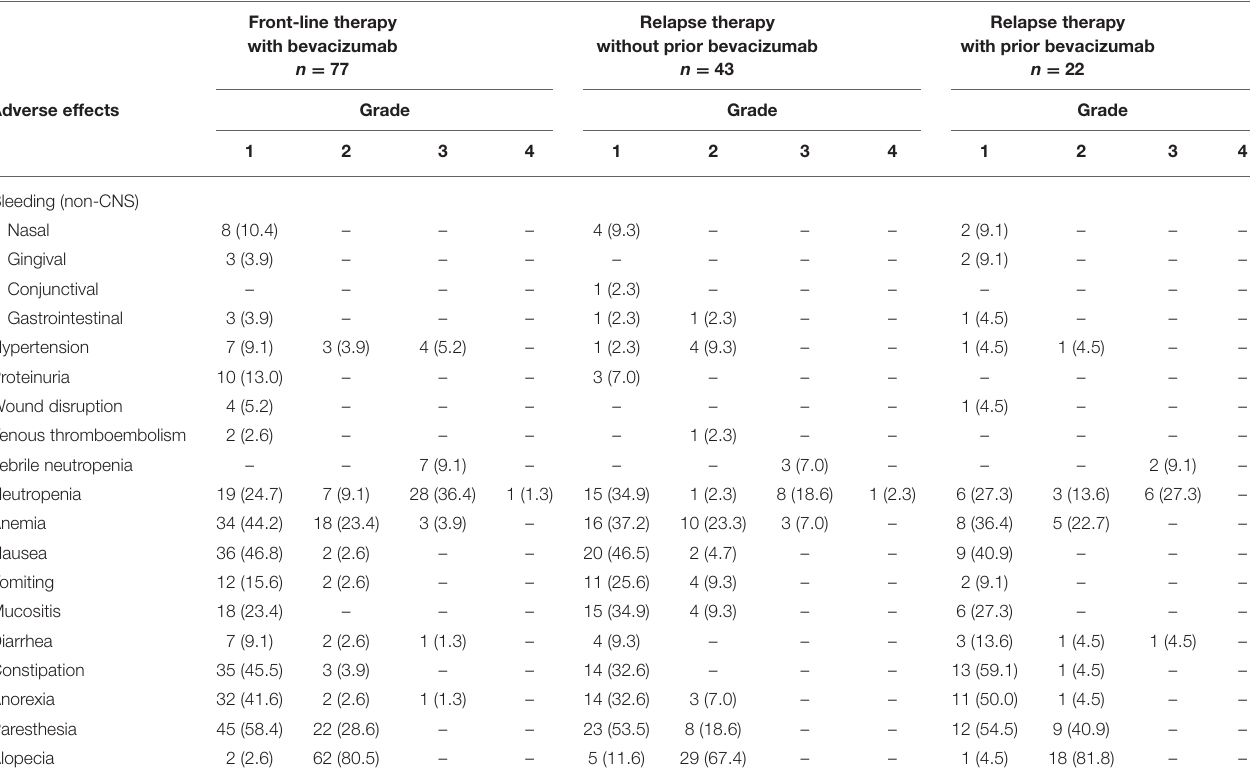
TABLE 5 | Adverse effects and grades in ovarian/tubal/peritoneal patients treated with bevacizumab plus chemotherapy ( N =